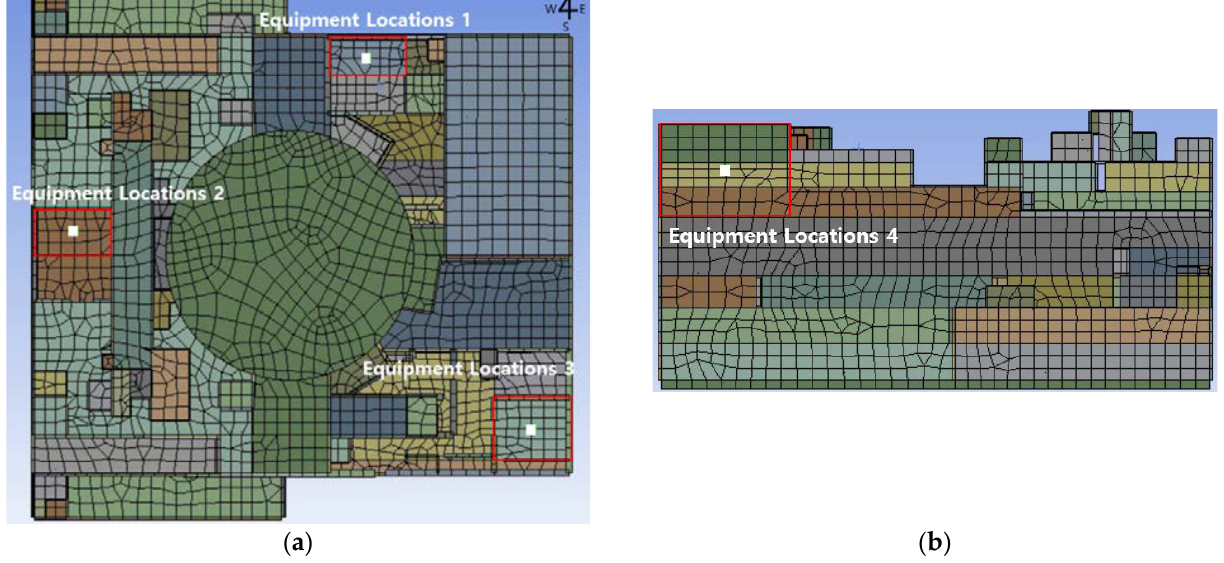
Figure 7. Monitored node: ( a ) 6 th- floor slab (25 m); ( b ) wall (north wall).